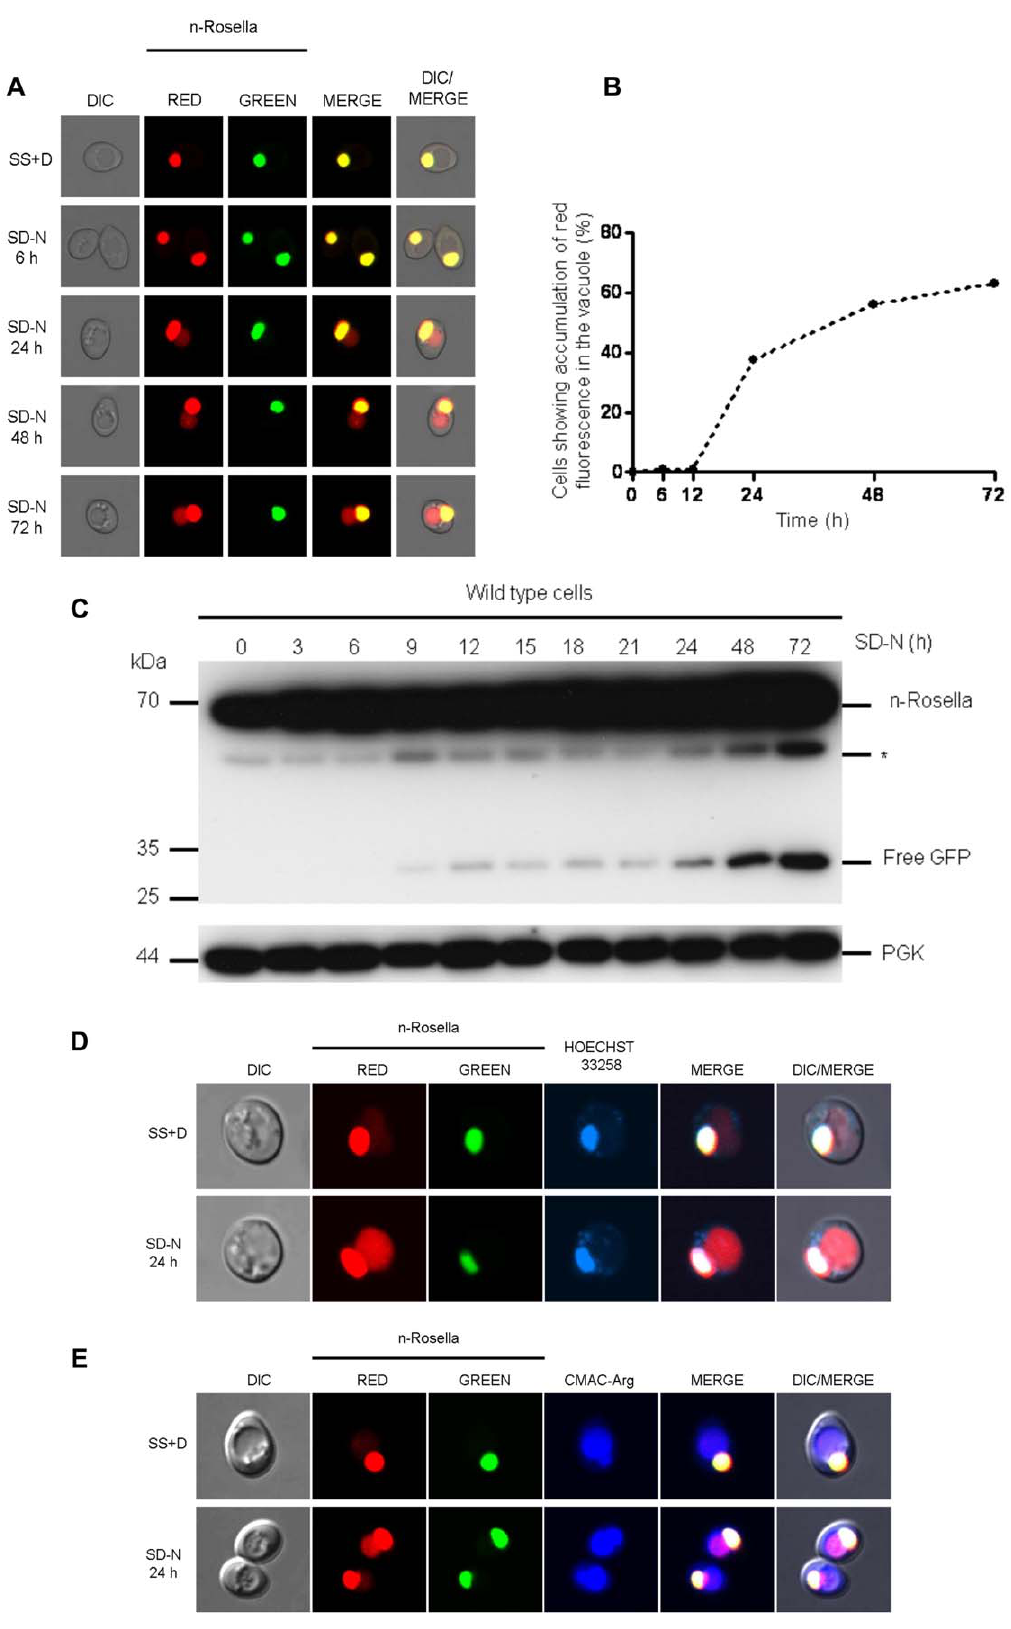
Figure 1. Delivery of n-Rosella to the vacuole of nitrogen-starved wild type cells. ( A ) Wild type (BY4741) cells expressing n-Rosella were subjected to nitrogen starvation and then sampled at selected time points (0, 6, 24, 48 and 72 hours after commencement of nitrogen starvation).